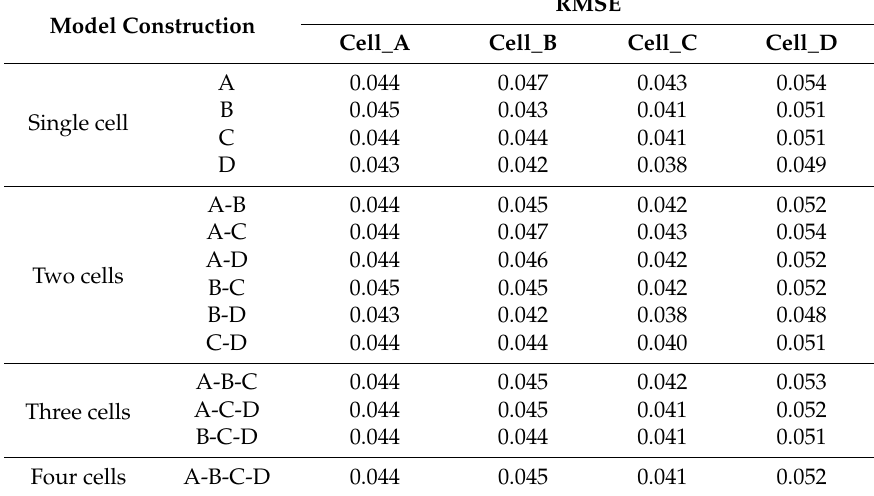
Table 6. RMSE of the SOH estimations using different cell(s) for the model